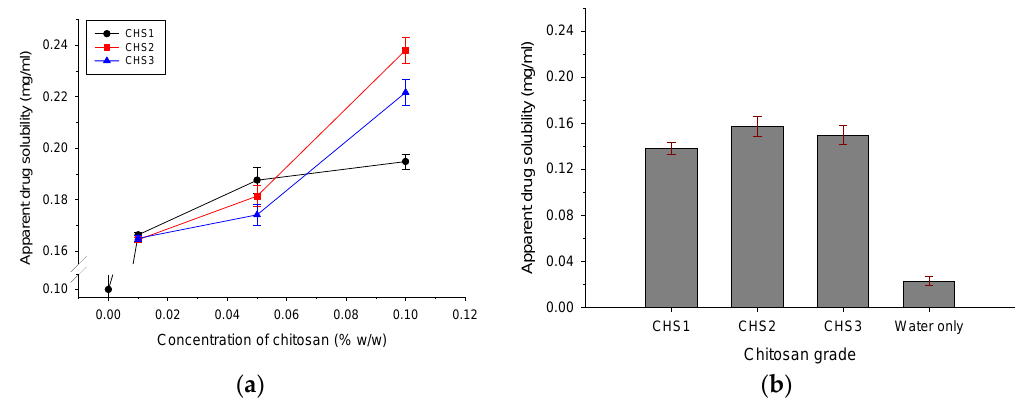
Figure 2. ( a ) Apparent solubility of piroxicam at pH 1.2 in the presence of increasing concentrations of low (CHS1), medium (CHS2), and high viscosity (CHS3) chitosan grades (error bars are standard deviations, n = 3). ( b ) Apparent solubility of piroxicam in deionized water (pH 5.6) in the presence of 100 mg chitosan suspended in 10 mL water.